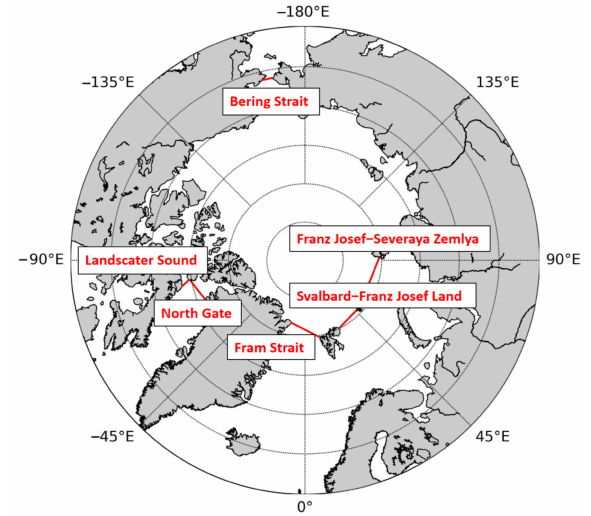
Figure 1. Locations of the six gates for the sea ice outflow